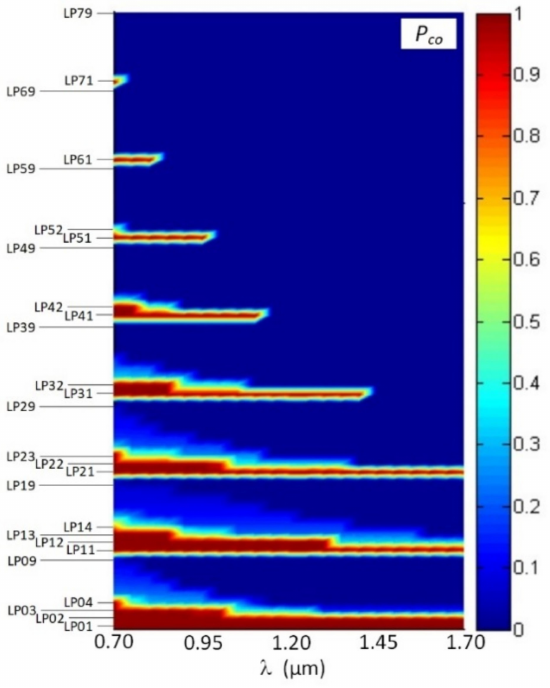
Figure 6. Diagram of the optical confinement factor distribution between modes of FMF 11/125 over the wavelength range λ = 700. . . 1700